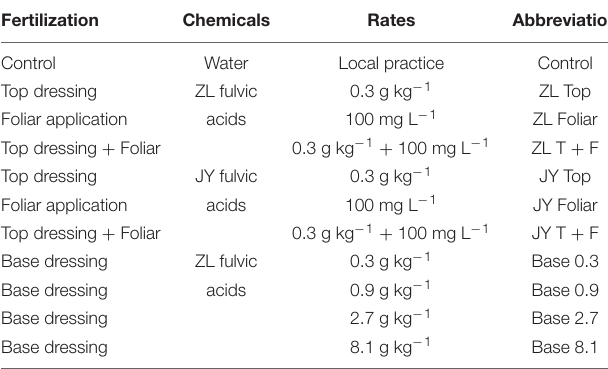
TABLE 2 | The treatments of soil culture for tomato growth (Experiment